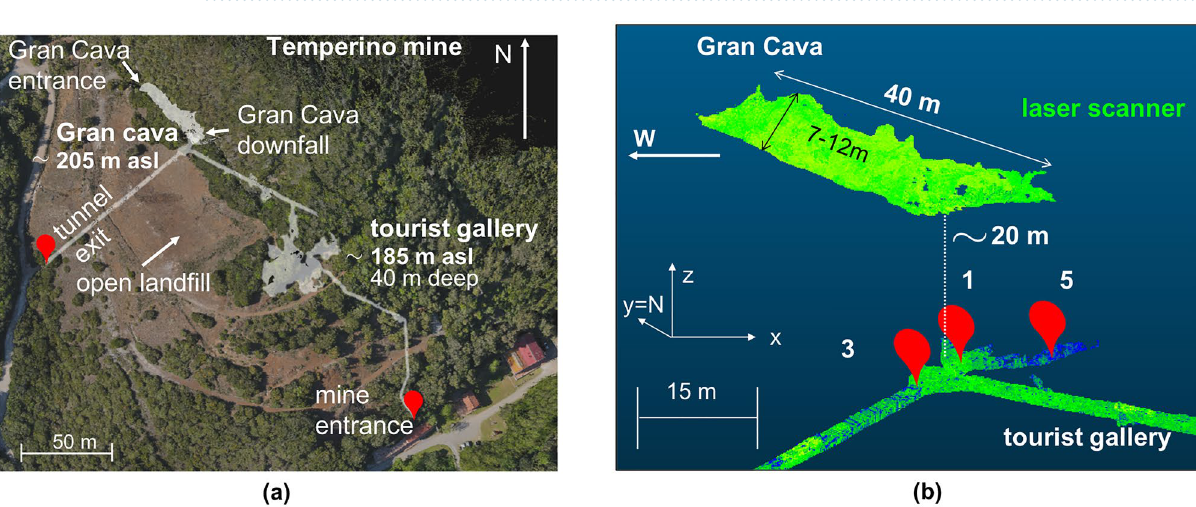
Figure 3. ( a ) the top view of the area of the Temperino mine (LI) in Tuscany obtained from a drone point cloud acquired for this study. The point cloud is displayed in CloudCompare 21 software. In transparency the gallery opened to the public (located about 40 m deep) and the Gran Cava, a known cavity, 20 m higher than the tunnel are shown. ( b ) localization of the measurement positions inside the tourist gallery. The figure shows the adopted three-dimensional Cartesian reference system with the positive direction of the y axis coinciding with the North